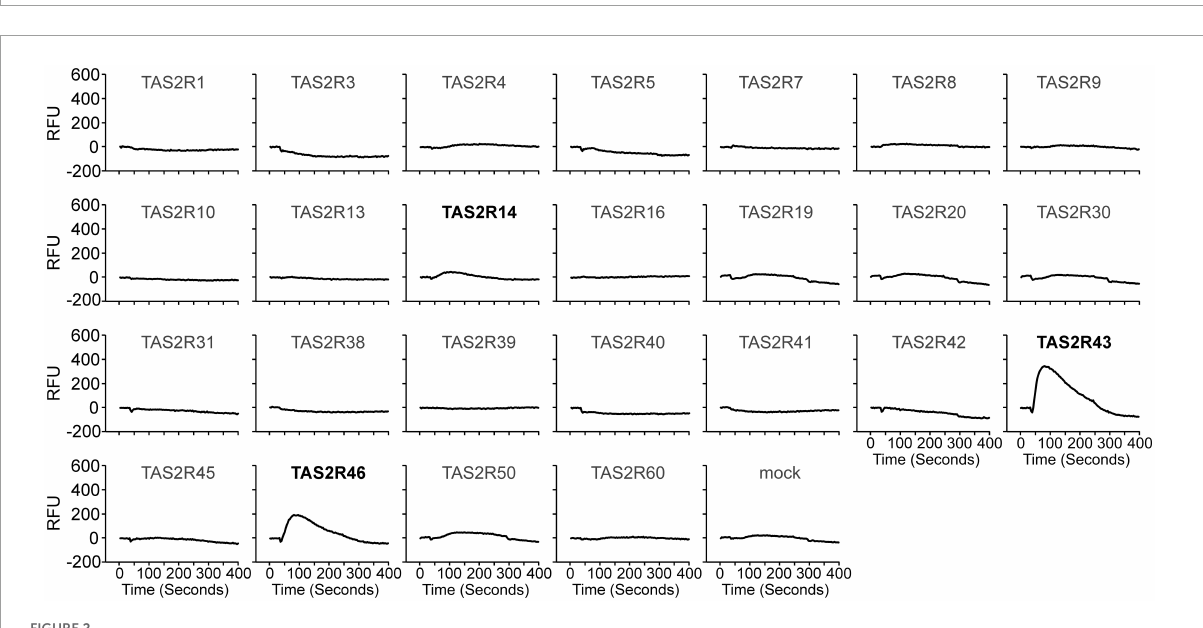
FIGURE2 Human bitter taste receptors responding to lactucopicrin. Fluorescence traces of HEK 293T-G α 16gust44 cells upon stimulation with 10 µ M lactucopicrin are shown. Lactucopicrin-activated receptors are printed bold and in black. As negative controls, cells were transfected with empty vector (mock). Y -axis, relative fluorescence units (RFU); x -axis, time in